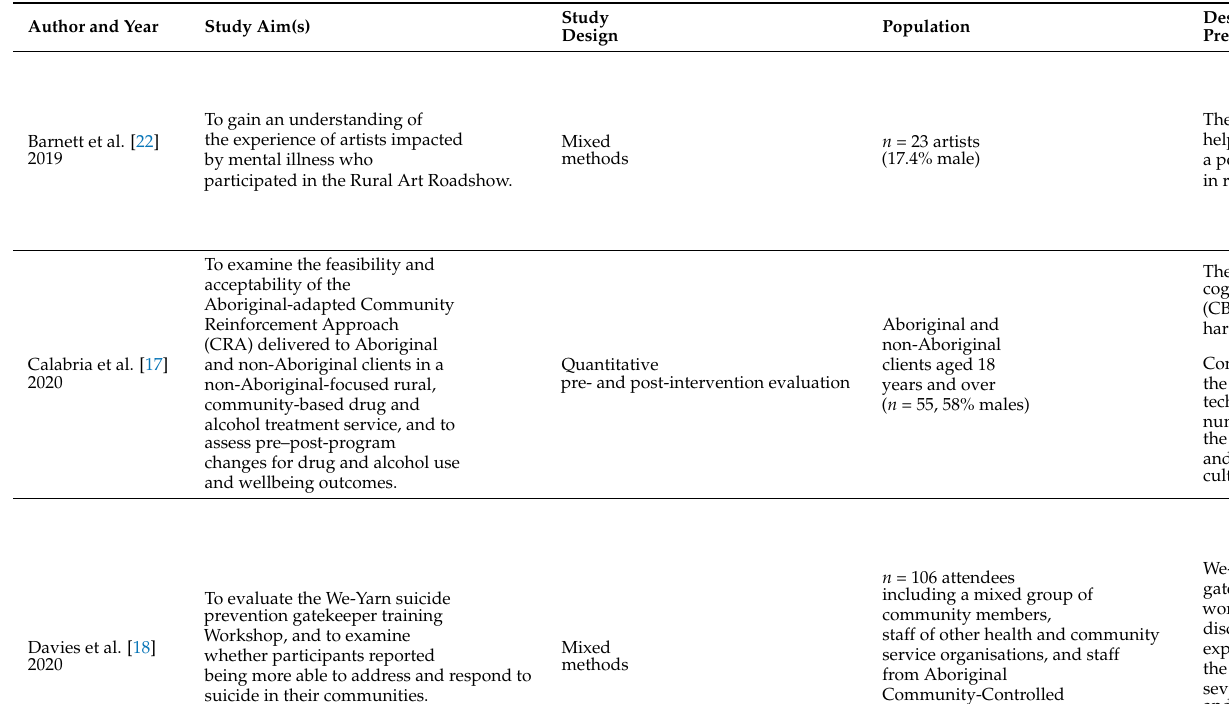
Table 3. Data summary of the included